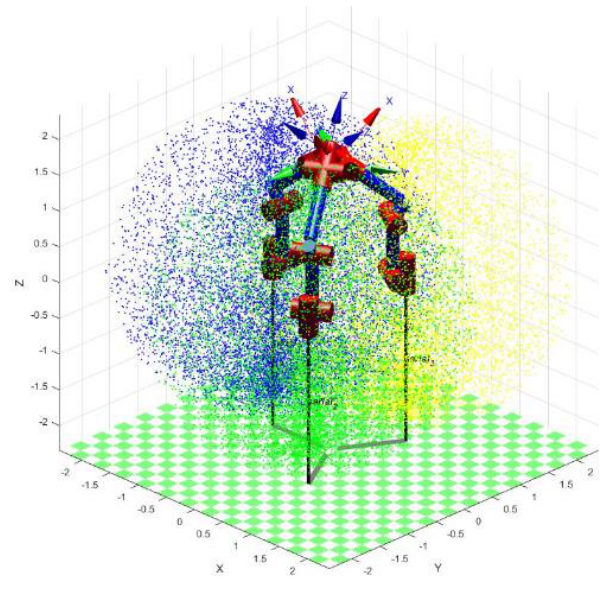
Figure 5. Workspace of the robotics.